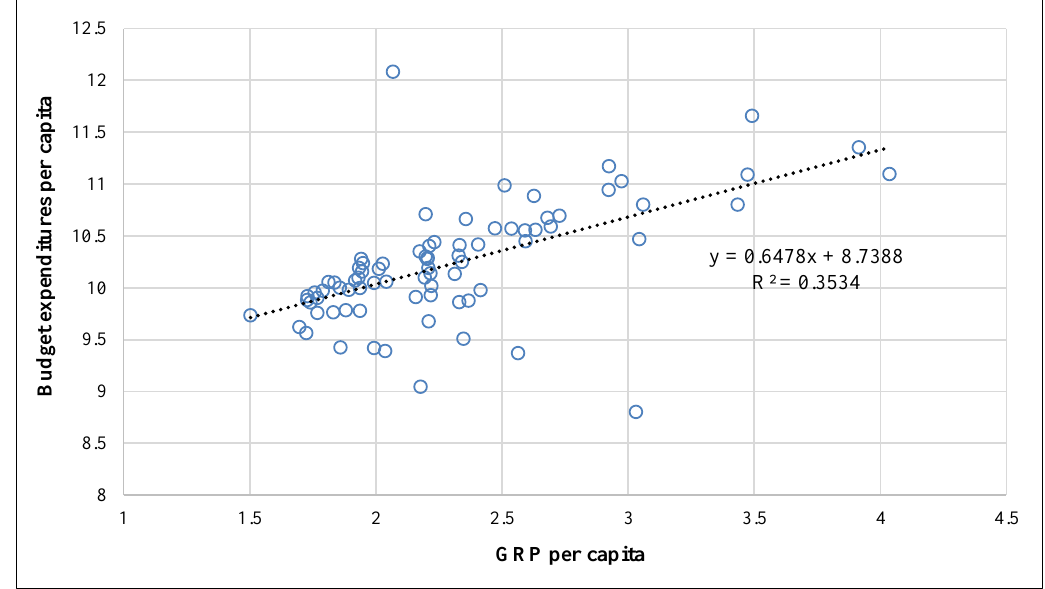
Figure 2. Ratio of the logarithm of the GRP per capita value and the logarithm of the budget expenditures per capita value in 2000